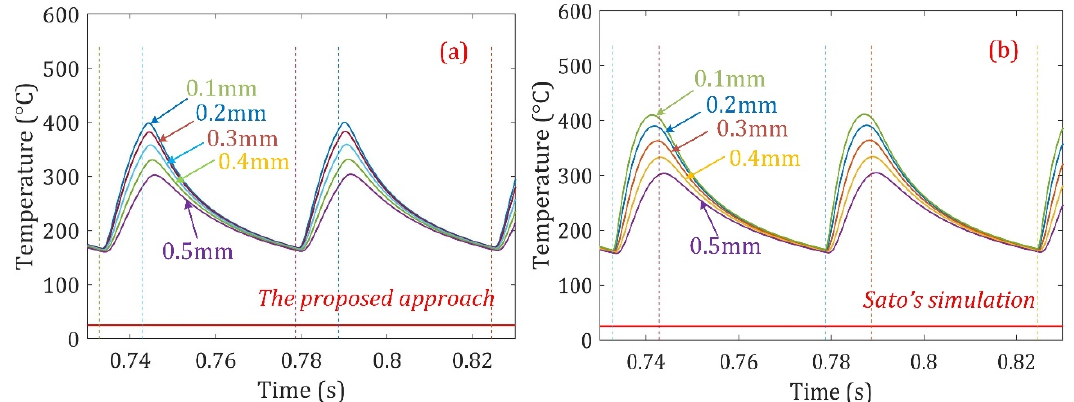
Figure 10. Temperature histories of different locations out of ( a ) the proposed method and ( b ) the simulation result obtained by Sato et al. [35]. Table 3. Differences between the predicted and experimental results by Sato et al. [35].